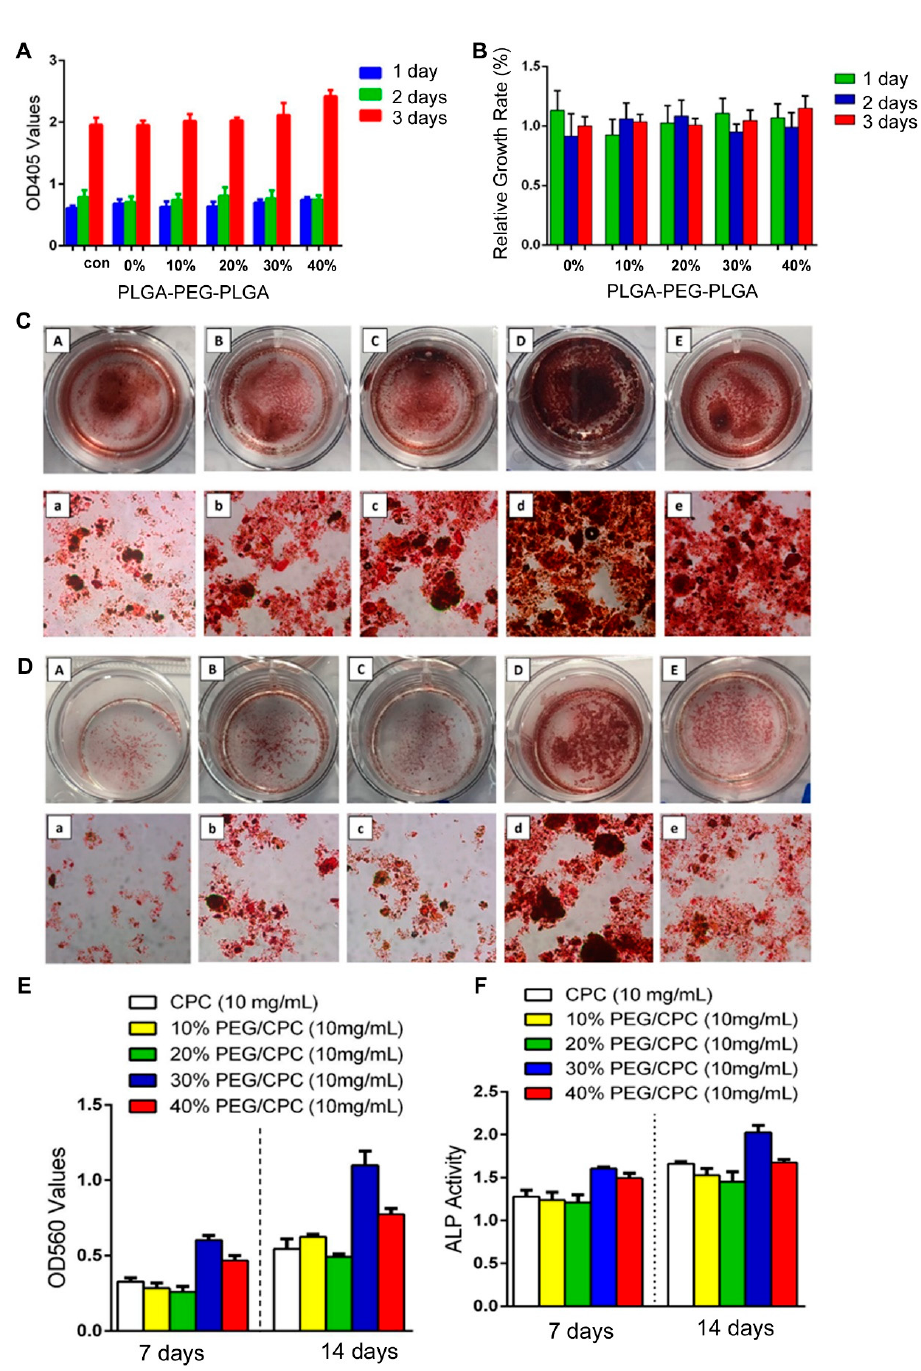
Figure 1. PLGA-PEG-PLGA/CPC composite bone cement significantly promotes the proliferation of osteoblasts and osteoinductive properties: ( A ) cytocompatibility of PLGA-PEG-PLGA/CPC bone cement; ( B ) relative growth rate of each proportion at different times (40 wt.% vs 0 wt.%: p = 0.032), with Alizarin Red stain results for various proportions in culture for 7 days ( C ) and 14 days ( D ) (A–E are 0 wt.%, 10 wt.%, 20 wt.%, 30 wt.%, and 40 wt.% PLGA-PEG-PLGA/CPC, respectively; a–e are the microscope images of A–E, respectively); ( E ) quantitative results of Alizarin Red staining in each group (30 wt.% and 40 wt.% vs. 0 wt.%: p = 0.028); ( F ) quantitative ALP activity results (30 wt.% vs 0 wt.%: p = 0.035) (OD405: optical density 405, OD560: optical density 560).